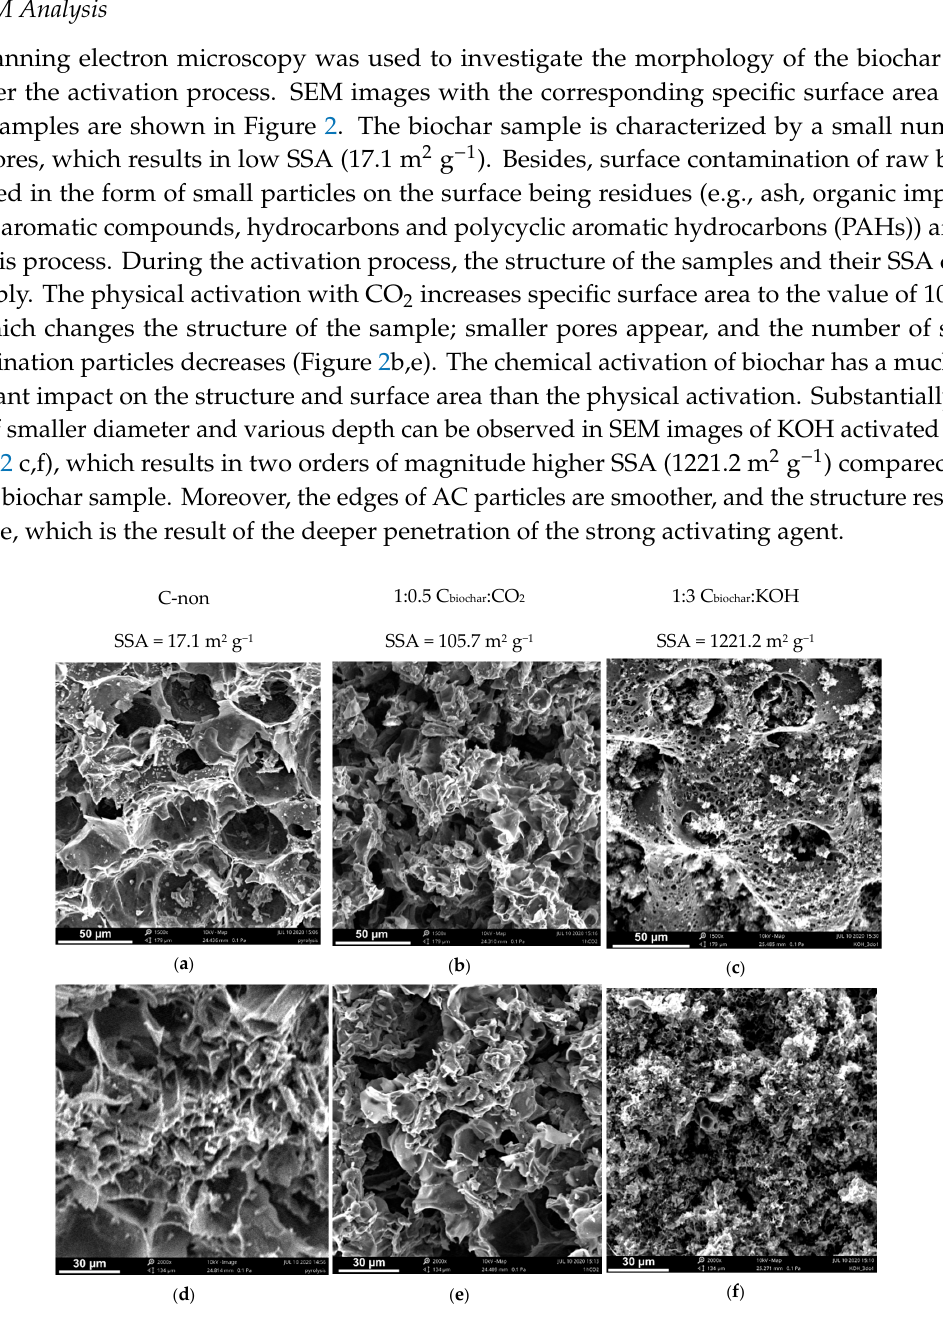
Figure 2. SEM images of: raw biochar ( a , d ); biochar after physical activation ( b , e ); biochar after chemical activation ( c , f ).